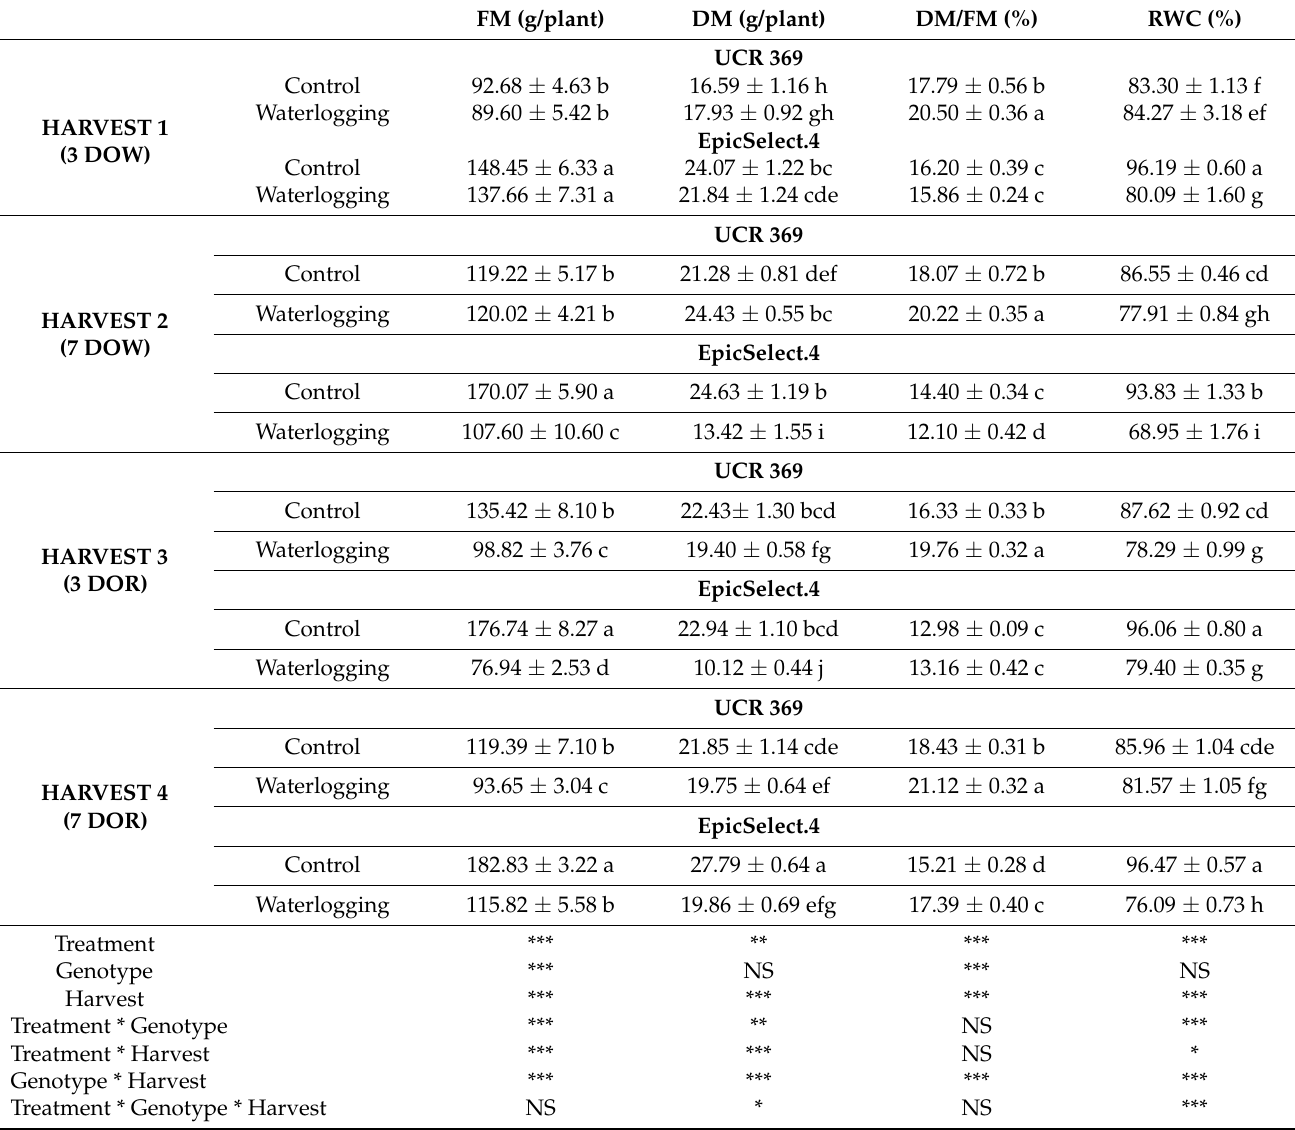
Table 1. Fresh (FM), dry mass (DM), dry mass to fresh mass ratio (DM/FM %), and relative water content (RWC) of UCR 369 and EpicSelect.4 cowpea genotypes under control and waterlogging treatments during 3 days of waterlogging (harvest 1), 7 days of waterlogging (harvest 2), 3 days of recovery (harvest 3), and 7 days of recovery (harvest